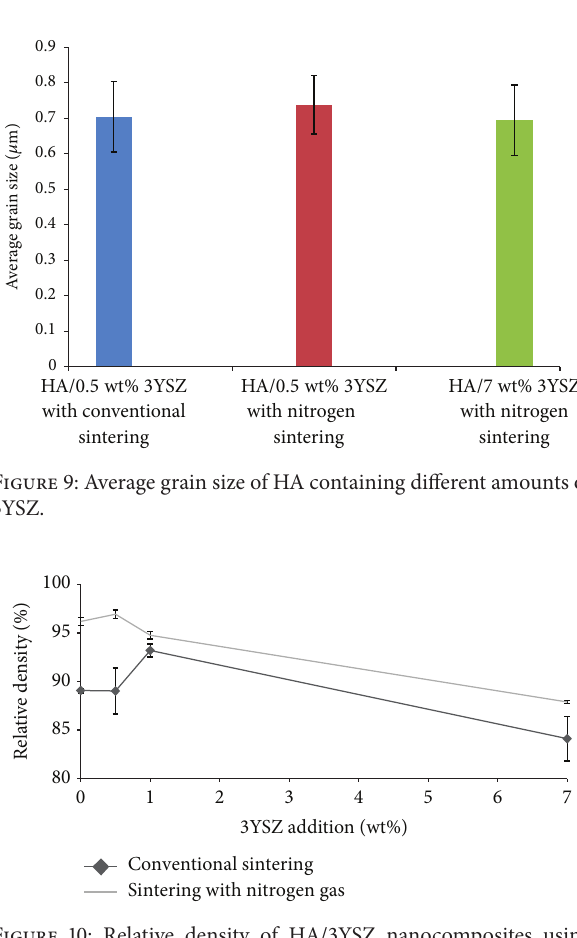
Figure 10: Relative density of HA/3YSZ nanocomposites using different sintering